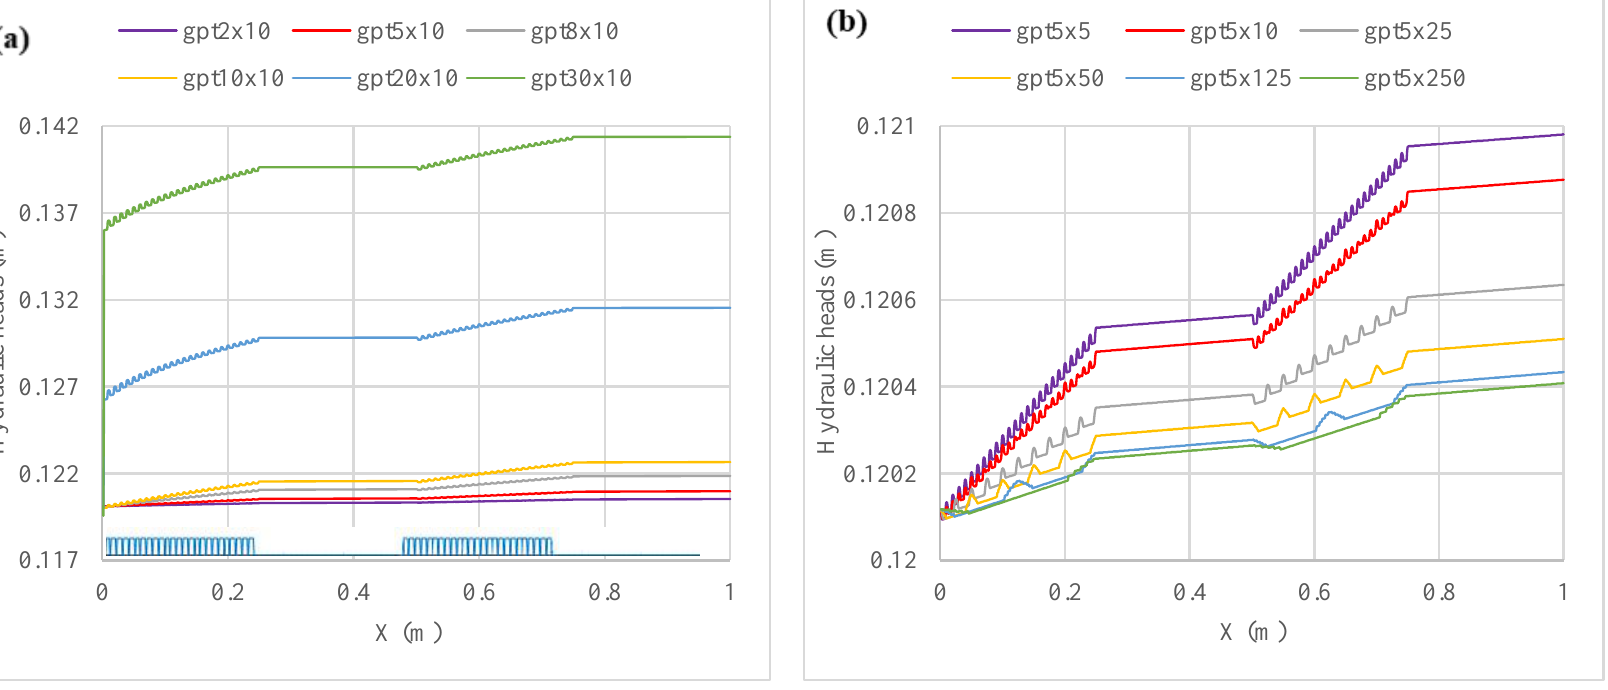
Figure 11. Variation in the distribution of hydraulic head due to a change in the shape of the gravel piece. In ( a ), height of the gravel piece was increased from 2 mm to 30 mm and in ( b ), base width of the gravel piece was increased from 5 mm to 250 mm to observe the change in the hydraulic head distribution.